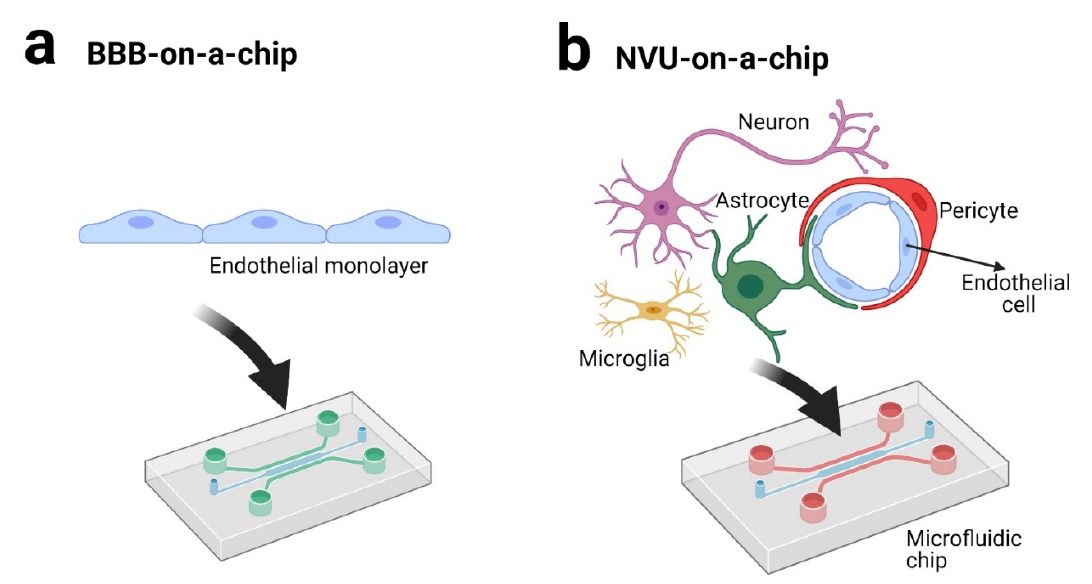
Figure 3. BBB-on-a-chip ( a ) and NVU-on-a-chip ( b ) technologies (created with BioRender.com [91]).